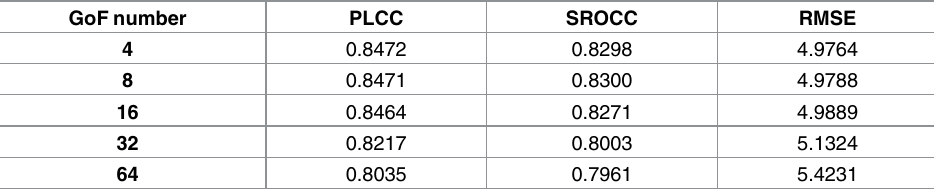
Table 1. Performance indicators of proposed VQA method with different GoF numbers.